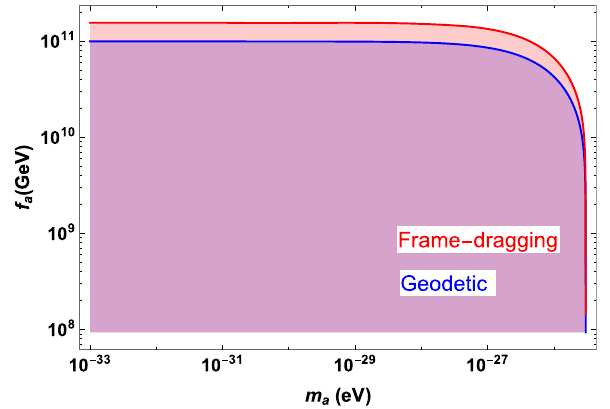
Fig. 1 Variation of f a with m a from geodetic (blue) and frame- dragging (red) measurements using GP-B result for a long range axion mediated force between a visible sector and a dark sector with fixed val- ues of the parameters η = 10 − 5 , c f = 1 , c D = 1. The shaded regions below these lines are